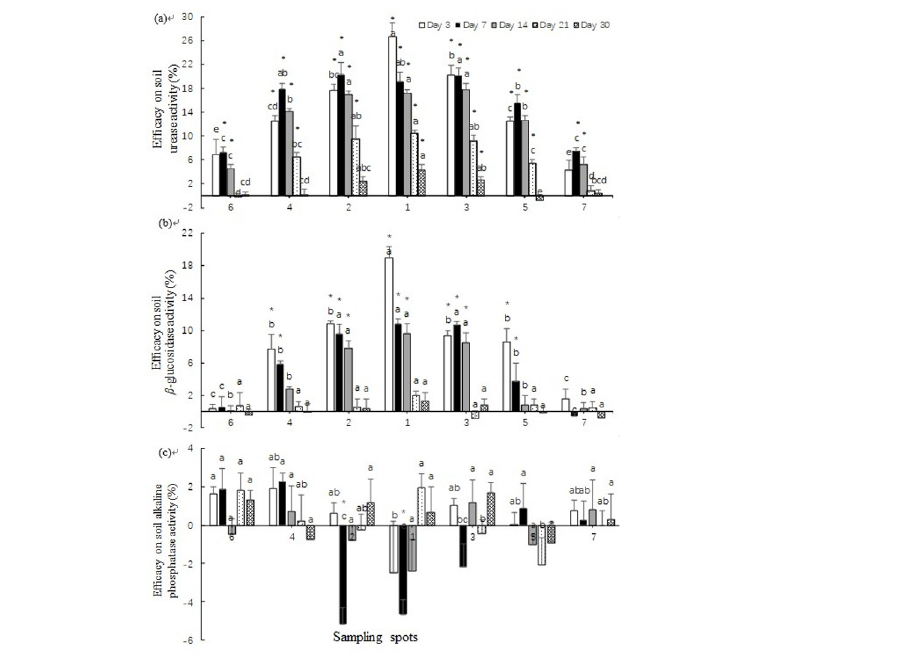
Fig 5. Effects of fluopyram on soil enzyme activity. (a) Soil urease. (b) Soil- β — glucosidase. (c) Soil alkaline phosphatase. Each column is the average value of the triplicates. The standard deviation is illustrated using an error bar. The significant differences among different sampling spots are illustrated using different letters above the columns at the p < 0.05 level via the least significant difference (LSD) test. Significant differences between treatment and control are illustrated using a “ � ” symbol above the columns at the p < 0.05 level via Tukey’s test.